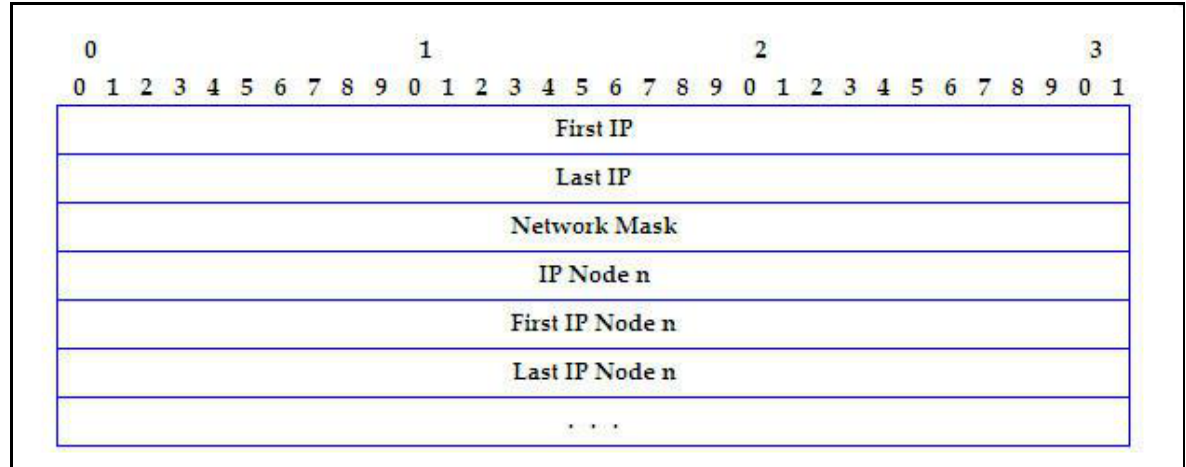
Figure 6. IP_ASSIGNED message format.